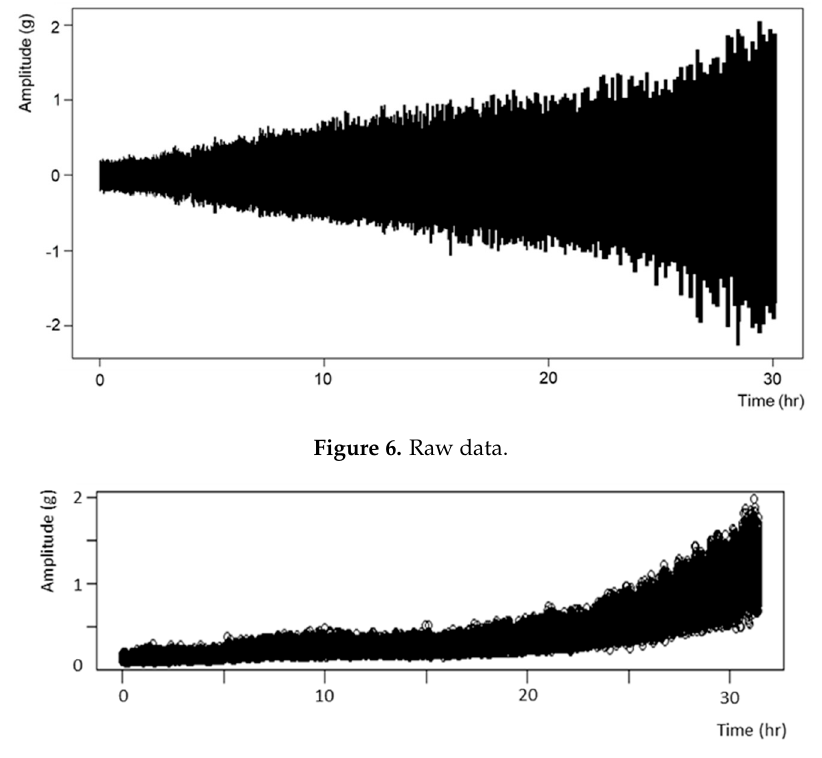
Figure 7. Aggregated data.